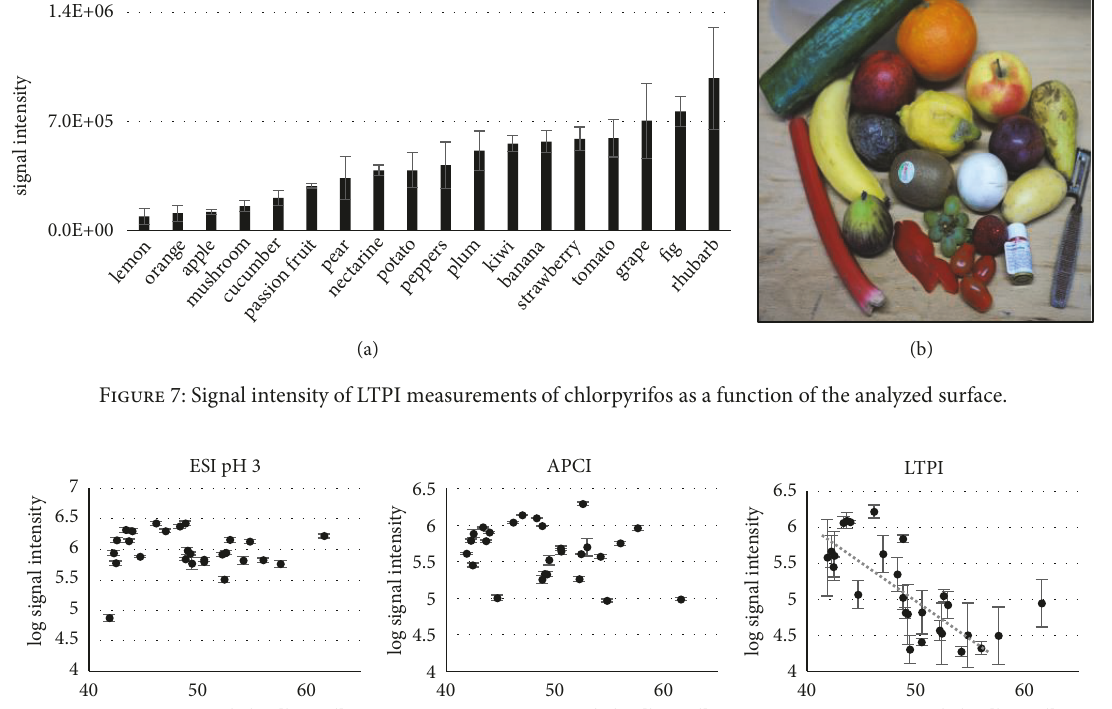
Figure 8: Log signal intensity (peak height)in dependency on the vaporization enthalpy for (a) ESI pH = 3, (b) APCI, and (c) LTPI (reprinted from [129] with permission by Springer